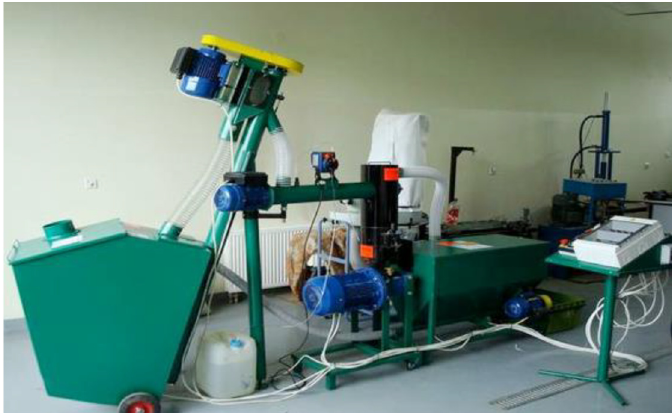
Figure 1. Kovo Novak pellet production line consisting of a hopper, granulation unit, and a cooler for finished pellets.